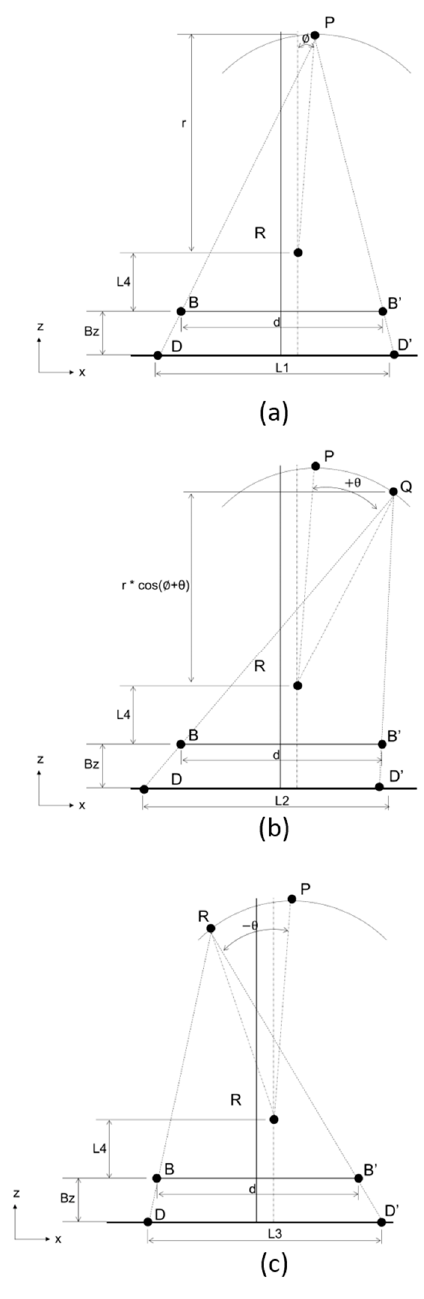
Figure 4. Flow chart of Step I. Step I calculates the distance (r) between the focal spot of the X-ray tube (Point P) and the rotation axis of the X-ray tube’s rotation structure, the angle ( ψ ) between the linking line of the focal spot (Point P) and rotation axis (PR) and the straight line orthogonal to the sensor, and the distance (L 4 ) between the rotation axis (Point R) and the linking line between the two steel balls of the phantom: ( a ) The actual hardware positions directly after assembly; ( b ) the X-ray tube’s focal spot rotates + θ ◦ ; ( c ) the X-ray tube’s focal spot rotates − θ ◦ . P is the position of the focal spot, R is the position of the rotation axis, B and B’ are the positions of the two steel balls on the phantom, and D and D’ are the positions of the projections of the two steel balls on the sensor.